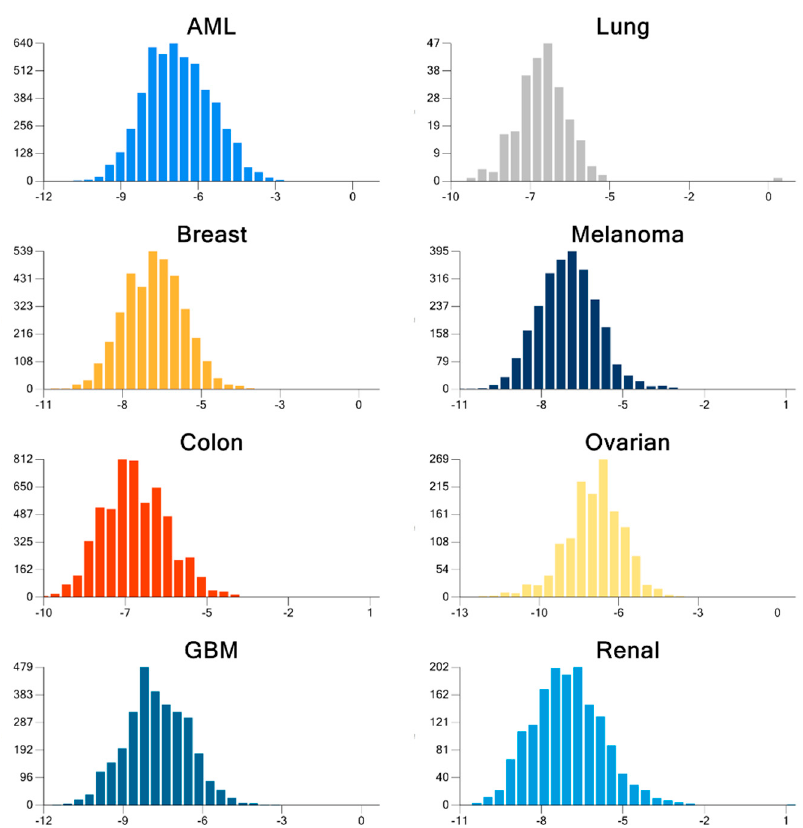
Figure 1. Distribution of the docking binding energy, BE (kcal/mol), from the best pose for all possible combinations of ligand-receptor pairs for each cancer. BE values < − 6 kcal/mol are considered significant.